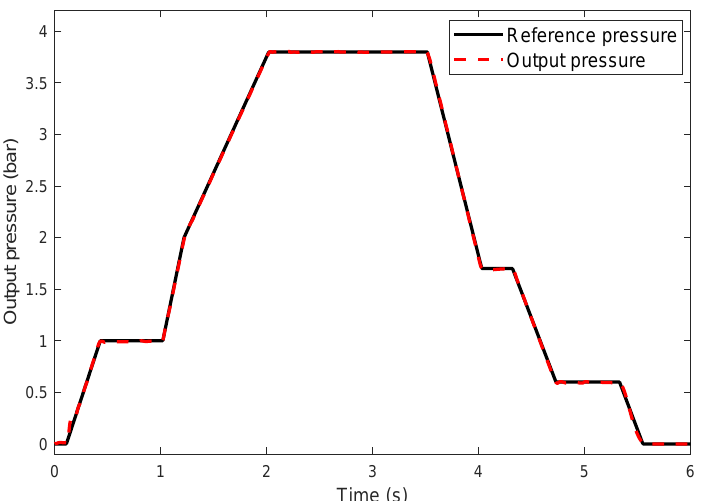
Figure 10. Comparison results between the reference pressure and the output pressure with the gain-scheduled MPC